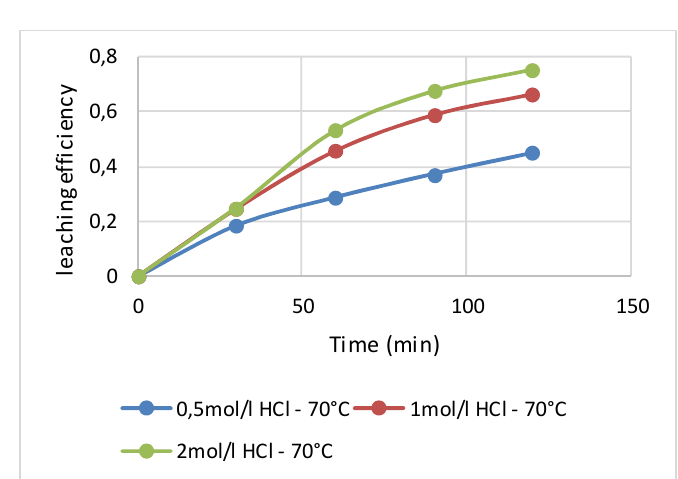
Figure 5 – Influence of the concentration of hydrochloric acid on yttrium dissolution Рис . 5 – Влияние концентрации соляной кислоты на процесс растворения иттрия Slika 5 – Uticaj koncentracije hlorovodoni č ne kiseline na rastvaranje itrijuma Under the same conditions, the dissolution of iron with hydrochloric acid is very high at 70°C for all used concentrations.